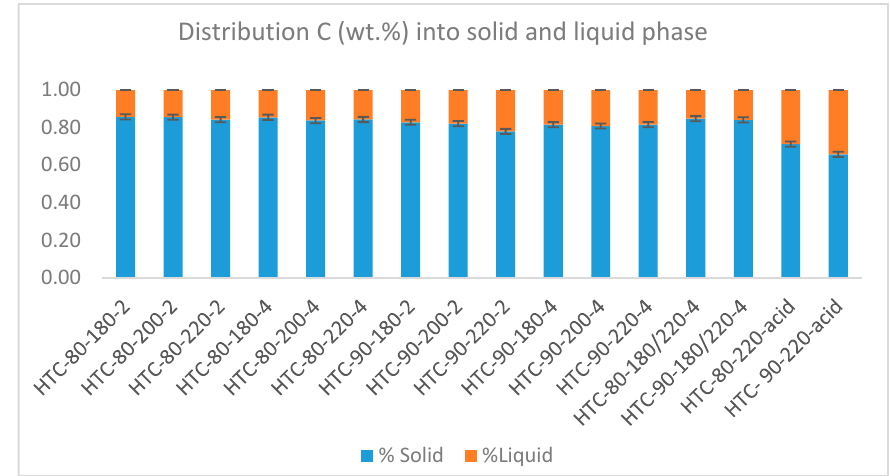
Figure 1. Distribution of C into solid, liquid and gas phase.